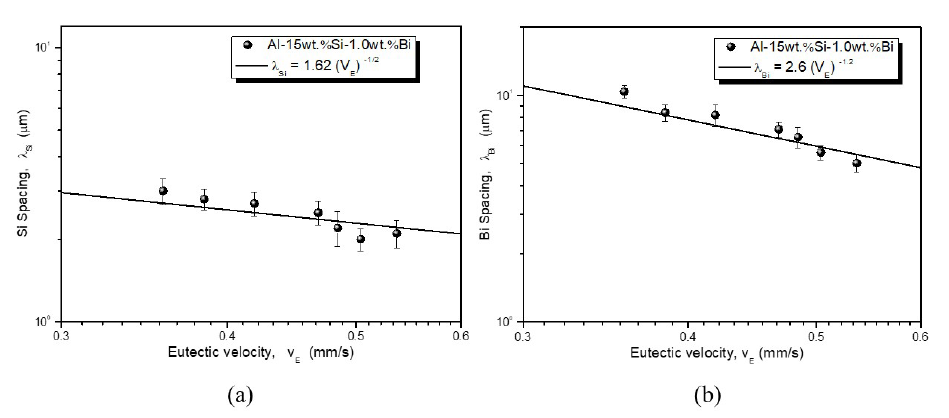
and (b) λ as a function of the eutectic growth velocity v Si Bi